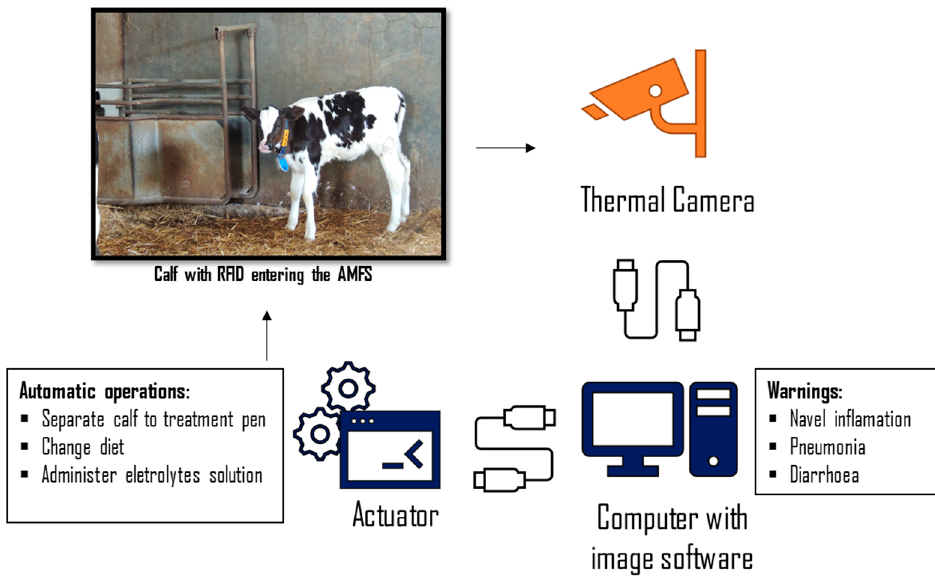
Figure 2. Schematic illustration of a theoretical infrared imaging-based machine vision (IRMV) system applied in a calf pen to provide warnings and automatic operations regarding calves’ health problems.